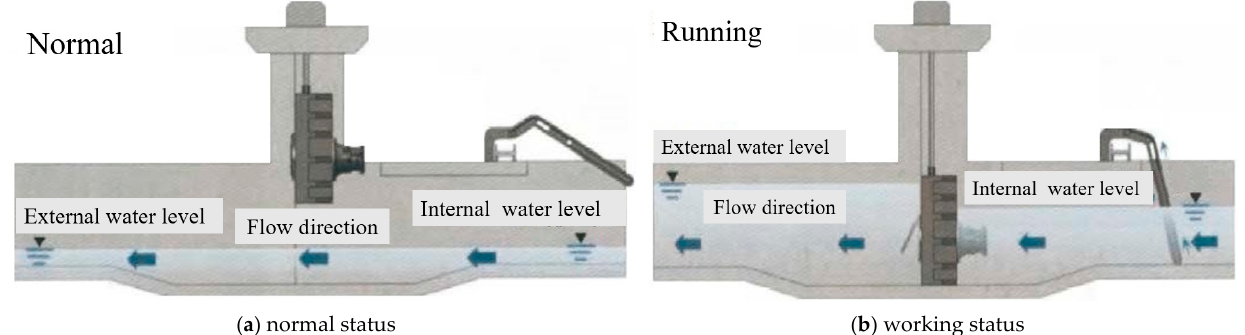
Figure 1. The working process of the integrated pump gate.